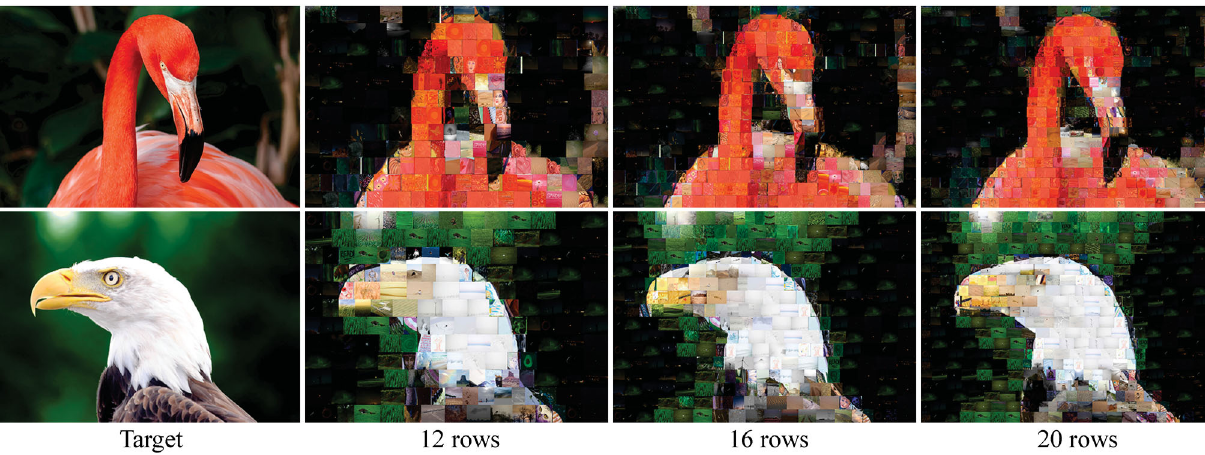
unacceptable, 3 adequate, and 5 perfectly